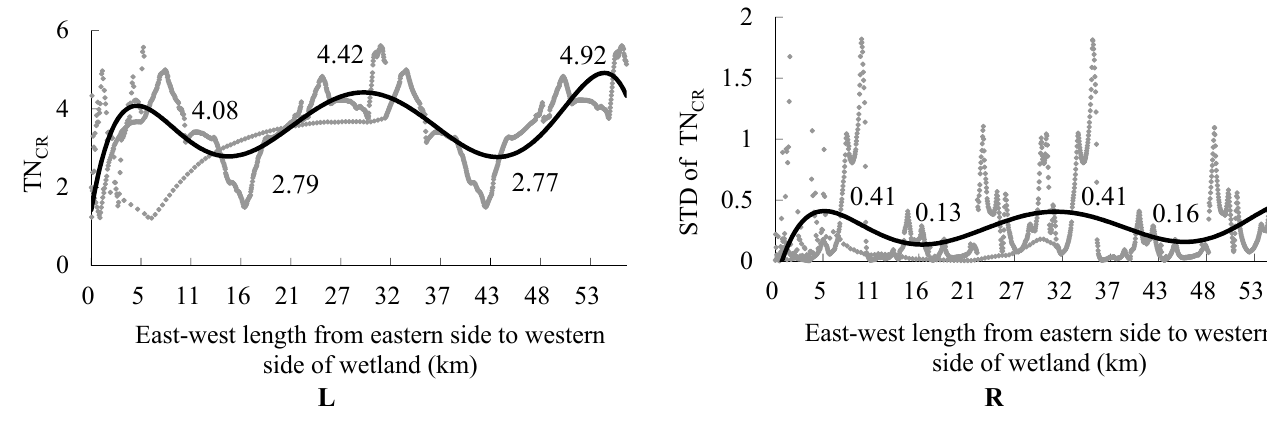
Figure 5. Mean and STD functions of TN CR (dependent index) and the distance of the water inlet (independent index) during the gradual buffer extrapolation, based on the water inlet as a start line in the Sanhuanpao wetland. The curve on the left ( L ) is the mean of TN CR , the curve on the right ( R ) is the STD of TN CR , and the numbers in the figure are the maximum and minimum values of the fitting